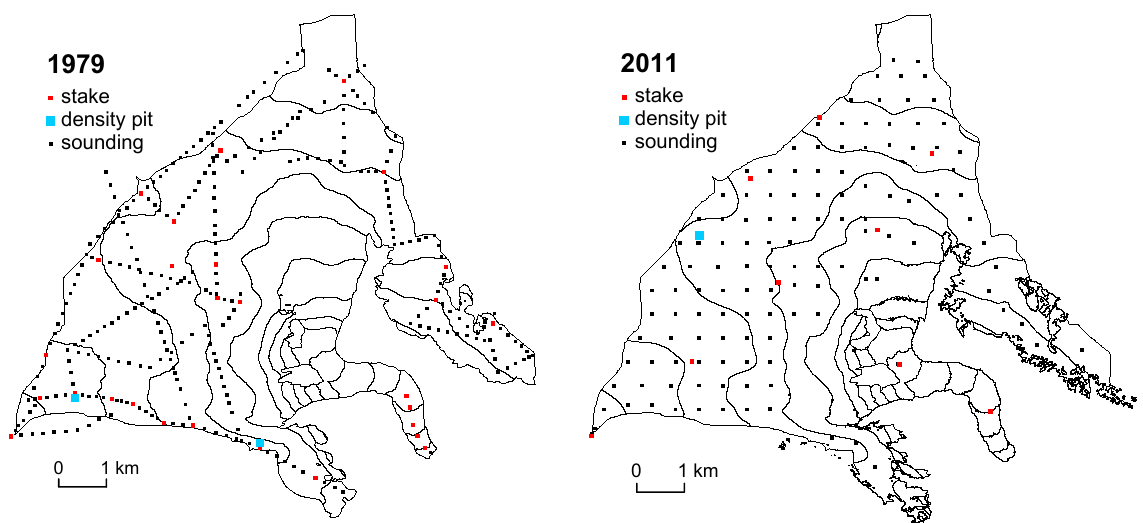
Figure 2. Typical stake network and snow depth soundings for Nigardsbreen. Non-glaciated areas within the basin are shaded in grey. The network in 1979 is representative for the period 1962–1981, whereas 2011 is representative for 2009–2014. The glacier outlines are from 1974 and